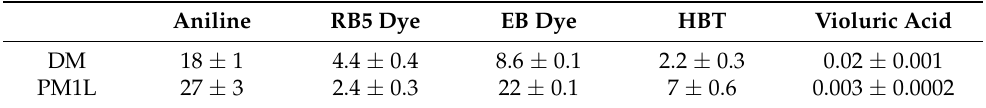
Table 5. Specific activities (U/mg) of DM laccase for the oxidation of aniline, RB5 and EB dyes, and violuric acid and HBT mediators.